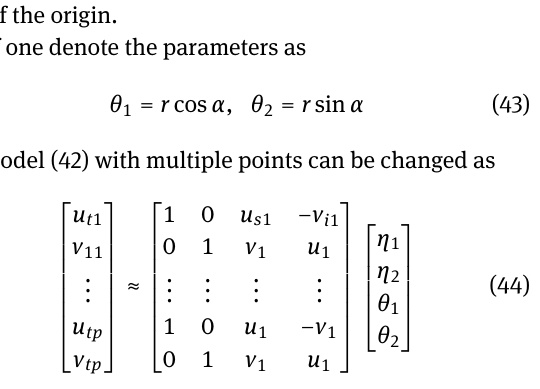
α is the rotation angle, η 1 and η 2 are the two shift param- eter of the